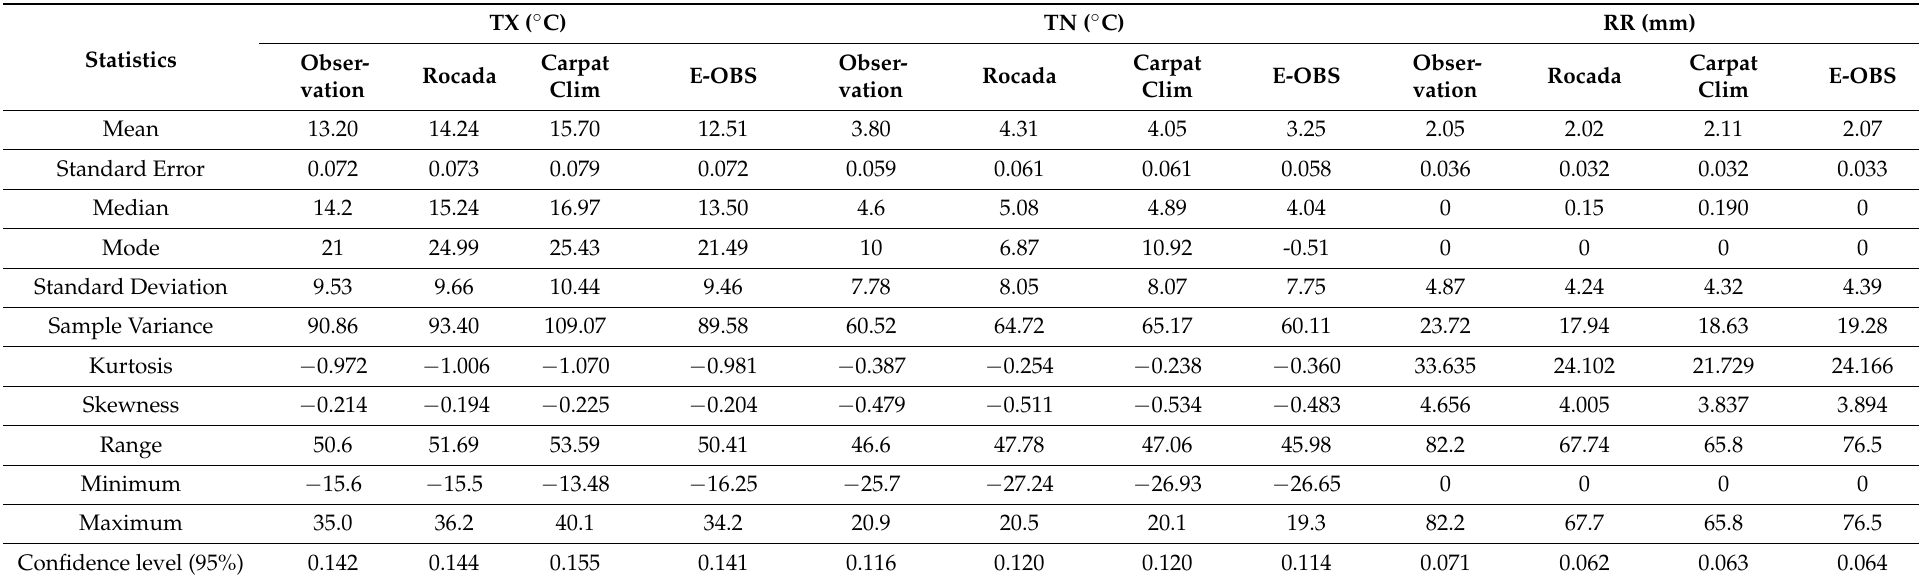
ugatag Meteorological ,